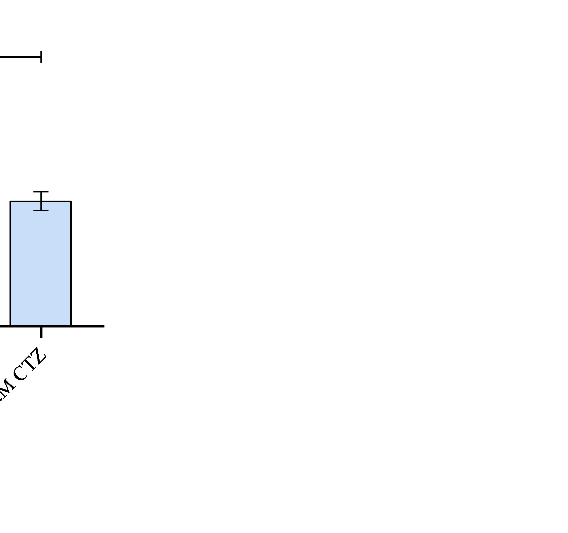
Figure 5. Bar graph representing ANS fluorescence intensity at 480 nm of fibrillated 10 µM HEWL incubated at pH2, 55 °C for 8 hrs in the presence of 10 µM and 100 µM of CTZ. ### p < 0.001, a significant difference from fibrillated HEWL.